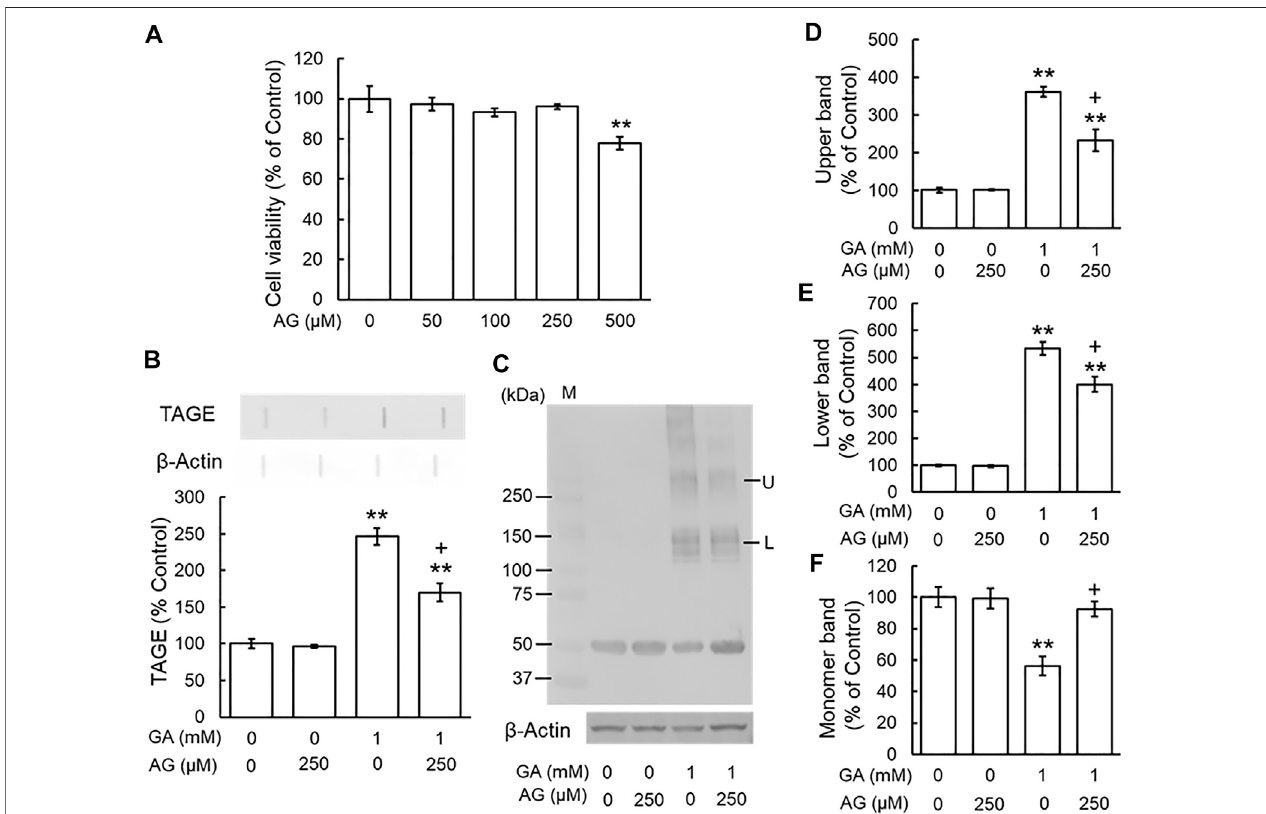
FIGURE 3 | AGinhibited TAGEformation and β -tubulinaggregation byGA. (A) Cellviability following AGtreatment.** p < 0.01vs.0 μ M ( n = 6). (B) The levelsofTAGE formationdeterminedbyslotblotanalyses.** p < 0.01vs.vehiclecontrol,+ p < 0.01vs.GAalone( n =3). (C) Thelevelsof β -tubulinweredetectedusinganti- β -tubulinantibody. M:Marker,L:lowerband,U:upperband. (D – F) Thelevelsofupper (D) ,lower (E) andmonomer (F) bandsoftheGA-treated β -tubulin.** p < 0.01vs.vehiclecontrol,+ p < 0.01 vs. GA alone ( n = 3).